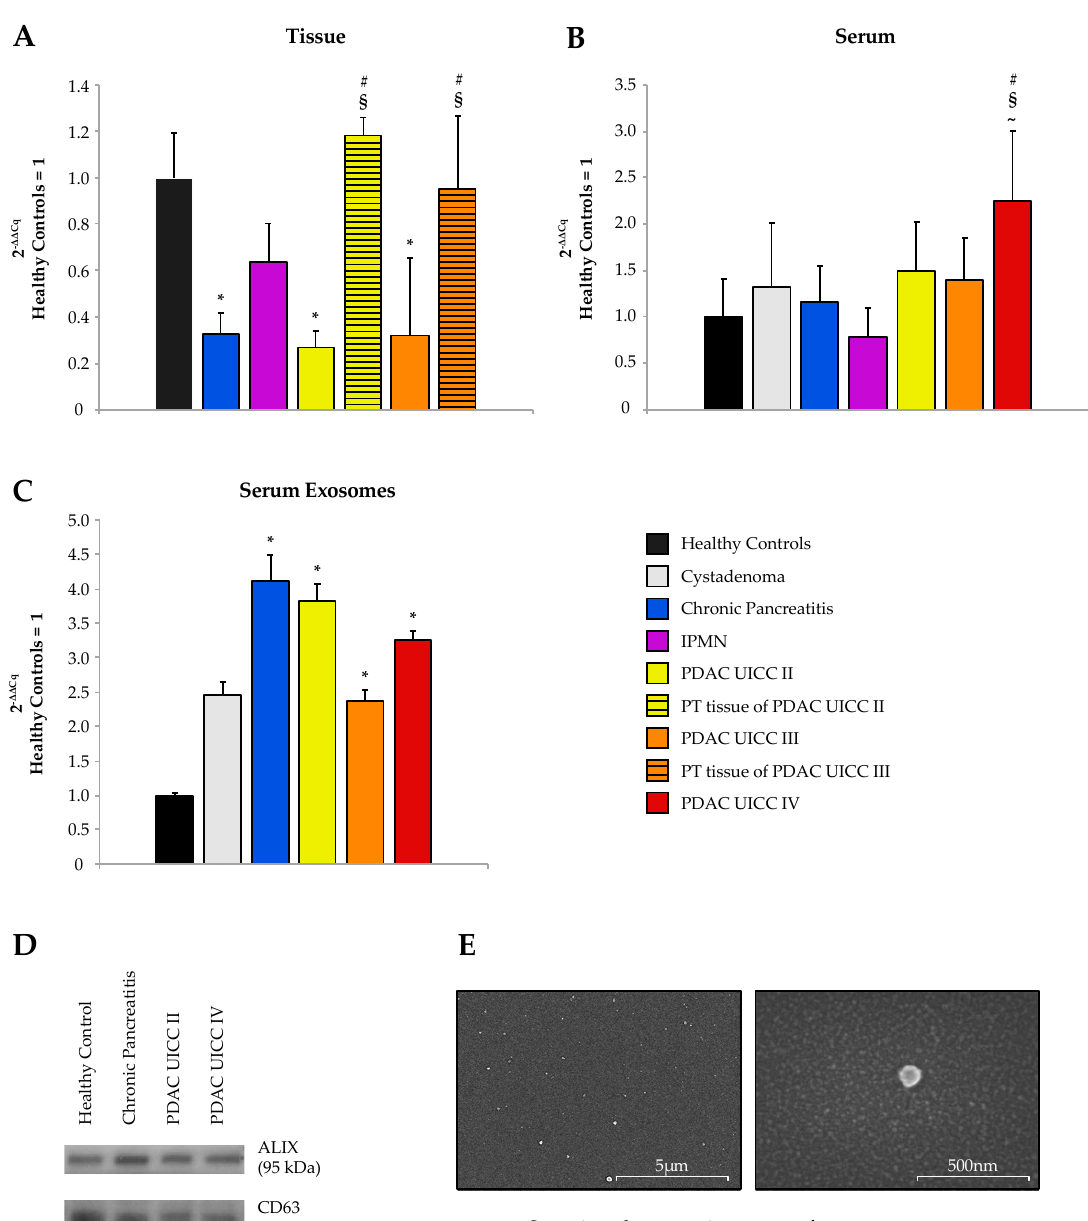
Figure 2. Expression of miR-192-5p in ( A ) tissue, ( B ) serum, and ( C ) serum exosomes. Data are plotted as 2 − ∆∆ Cq ± standard error of the mean (SEM) and relative to healthy controls. Statistical significance (assumed at p ≤ 0.05, Kruskal–Wallis test) is indicated as follows: to healthy controls (*), to chronic pancreatitis (#), to intraductal papillary mucinous neoplasm (IPMN) (~), and to tumoral tissue of the same UICC (Union for International Cancer Control) stage (§). ( D ) Western blot for exosomal markers ALIX (apoptosis-linked gene 2—interacting protein X) and CD63 (cluster of di ff erentiation 63) on exosome samples purified from patients’ blood serum. ( E ) Exemplary images of scanning electron microscopy of CD63 positive serum exosomes at magnifications of 10,000 and 100,000. Detailed information about western blot can be found at Figures S2 and